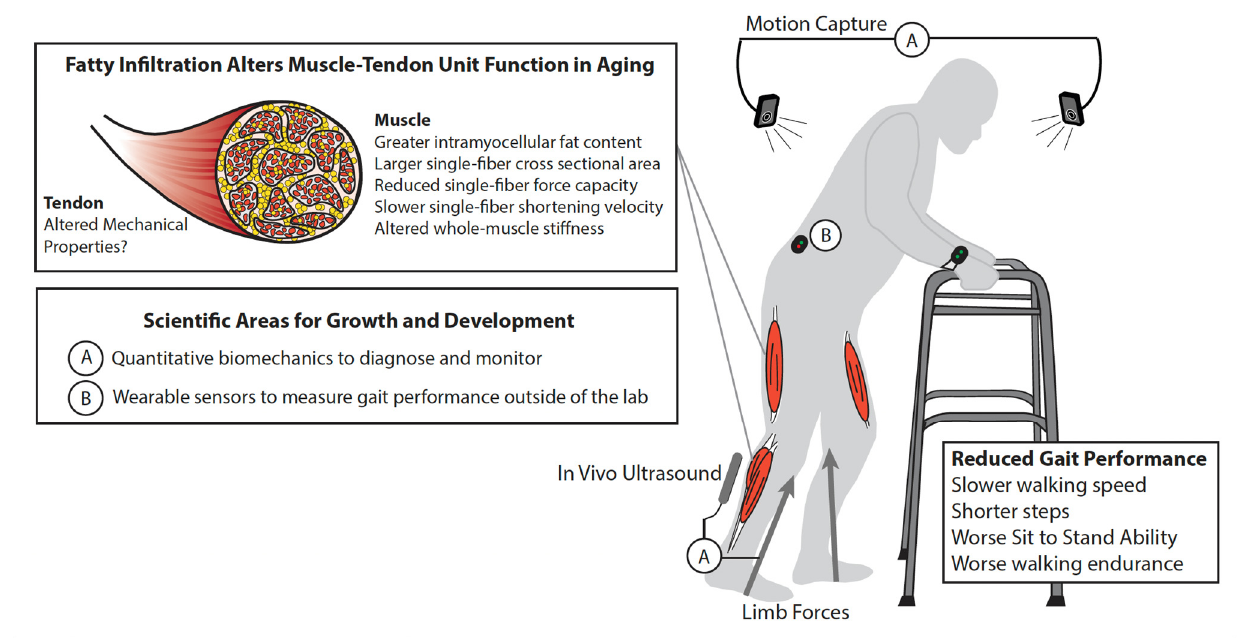
Figure 3. Multi ‐ scale biomechanics and gait performance. Schematic illustrates the musculoskeletal cascade from the accumulation of intramuscular fat to reduced gait performance among older adults. This is also simultaneously emphasized, and discussed in the narrative: ( A ) the need for quantitative biomechanics to objectively diagnose and monitor the salient features of gait quality, including step length, width, and frequency, ground reaction forces, joint mechanics and energetics, and patterns of muscular recruitment in people with sarcopenic obesity, and ( B ) the evolution and widespread adoption of wearable sensors that continue to break down barriers to clinical transla ‐ tion.